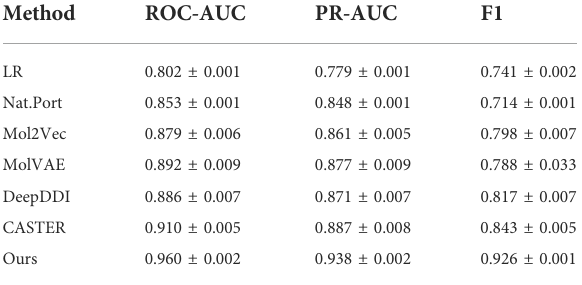
TABLE 4 Results of DDI experiments on BIOSNAP dataset.